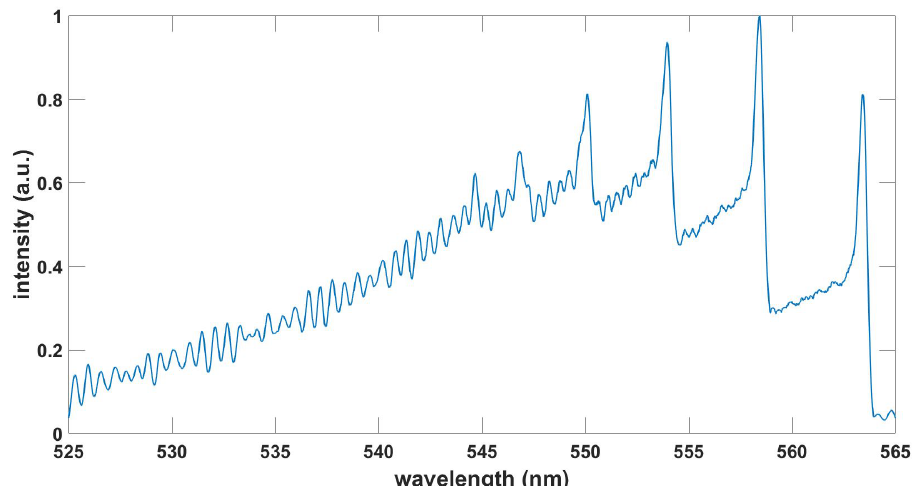
Figure 2. Computed C 2 Swan spectrum, ∆ v = − 1, δ λ = 0.39nm, T = 6.75 kK.